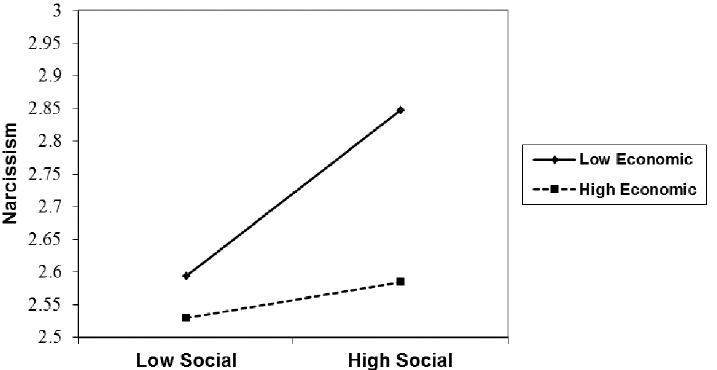
Figure 2. The Study 1 interaction between social and economic political ideology in relation to Narcissism.